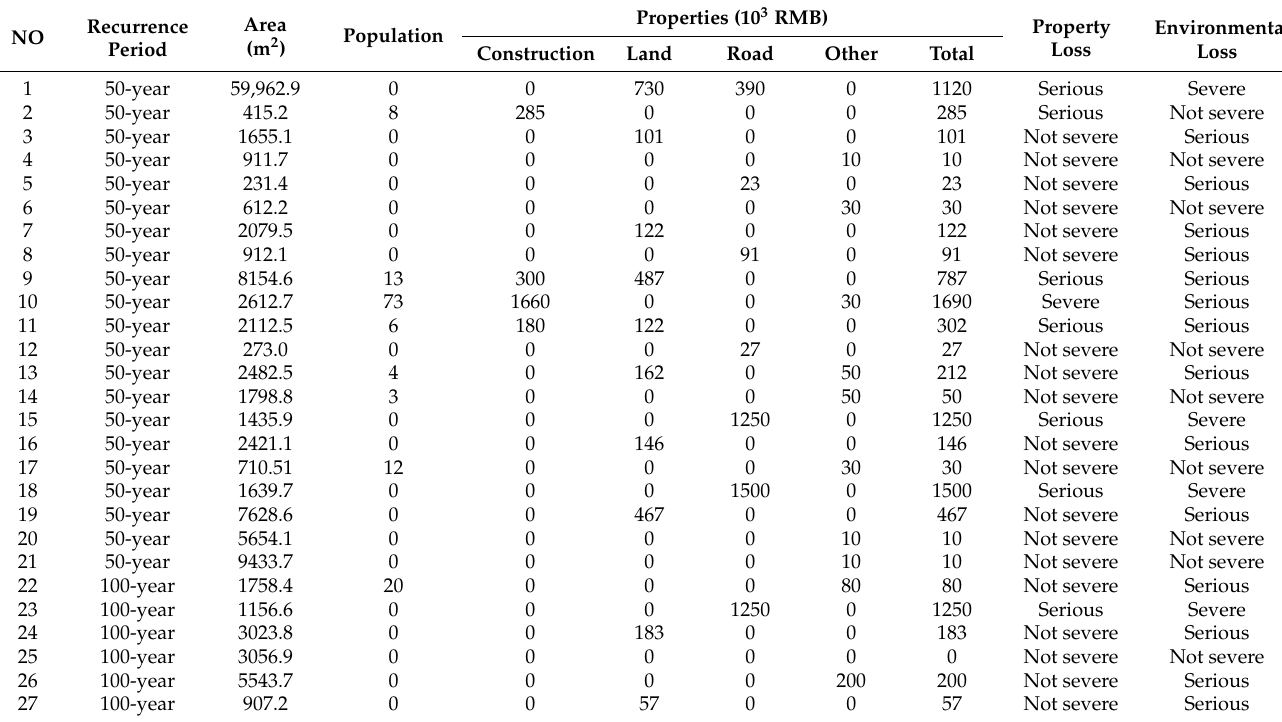
Table 7. Twenty-seven units for risk assessment and their potential damage under different return- period rainfalls.